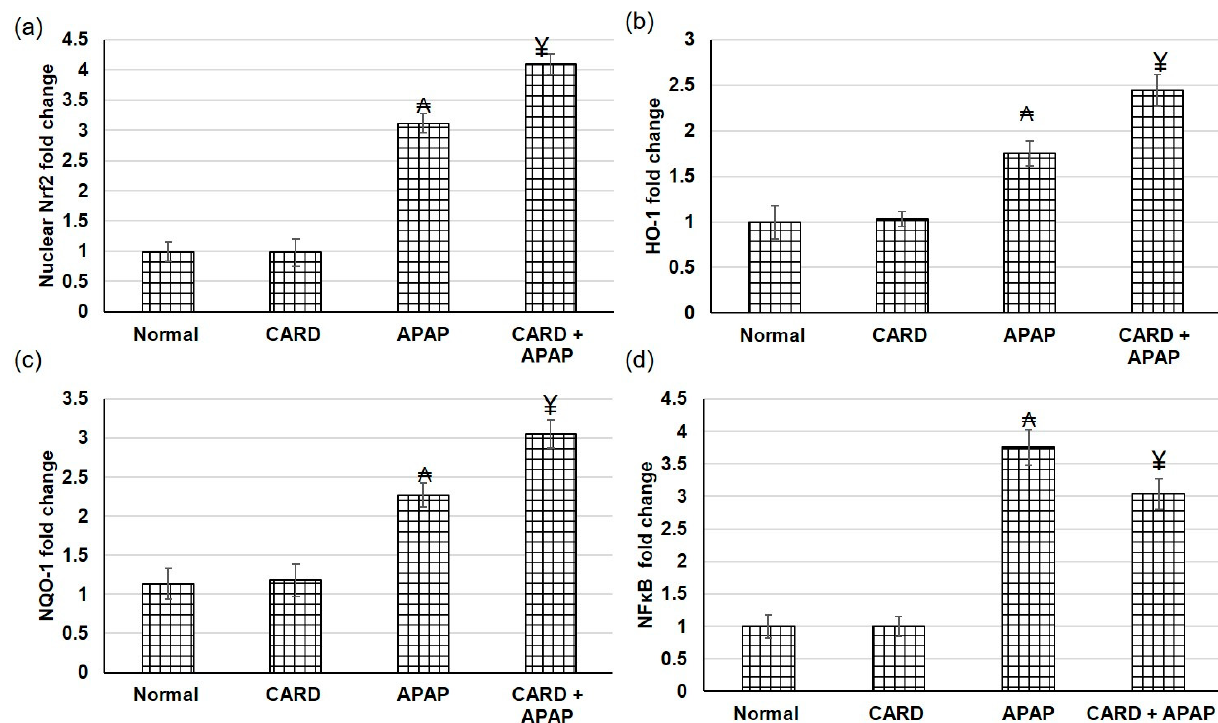
Figure 4. Effects of CARD aqueous extract (200 mg/kg) administration for 15 days prior to APAP Figure 2. Effects of CARD aqueous (200 mg/kg) extract administration for 15 days prior to APAP administration (300 mg/kg) on gene (mRNA) expression levels of ( a ) Nrf2, ( b ) HO-1, ( c ) NQO-1 administration (300 mg/kg) ( a ) DPPH and on the hepatic function tests, including ( b ) ALT, ( c ) AST, and ( d ) NF- κ B, respectively, in APAP-induced acute hepatic failure in mice. All values are stated as ( d ) ALP and ( e ) LDH in APAP induced acute hepatic failure in mice. All values are stated as mean ± SD. ₳ designates statistically significant compared to the normal group and ¥ designates statistically mean ± SD. significant compared to the APAP group ( p < 0.05) using one-way ANOVA followed by Tukey’s post hoc test. Tukey’s post hoc test.